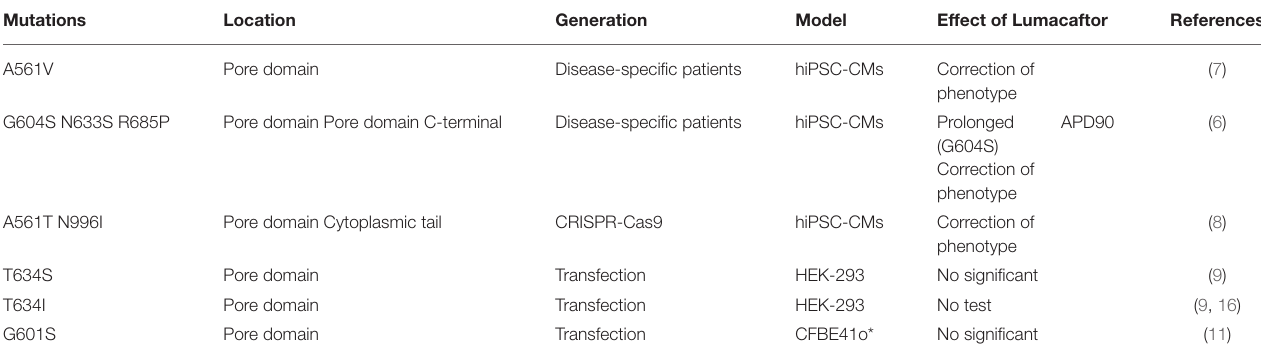
TABLE 1 | The effect of the chemical chaperone Lumacaftor on different mutation sites of hERG full-length channel protein.